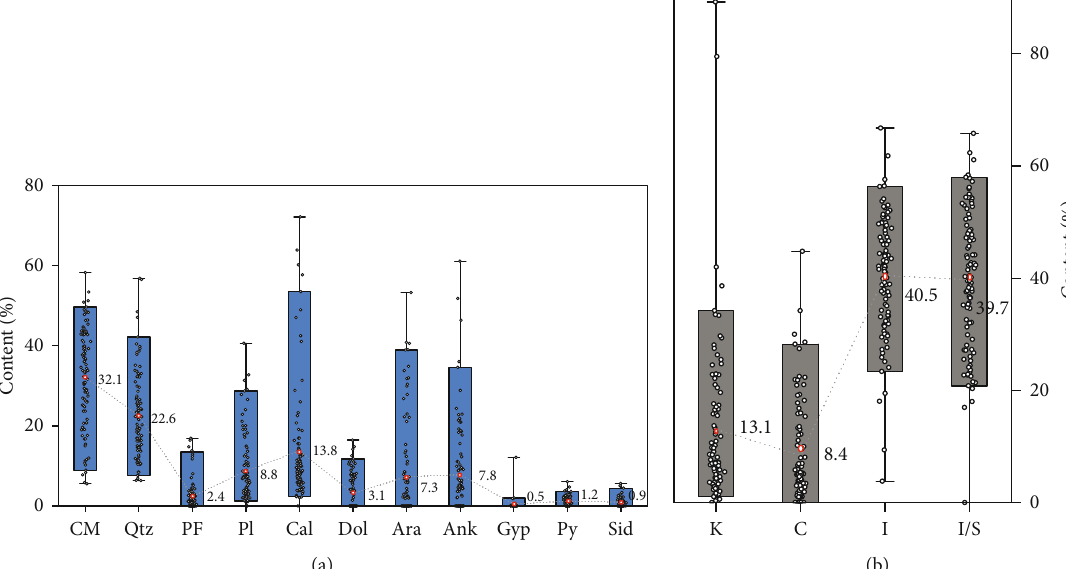
in the Es 1L of the Raoyang Sag. 1